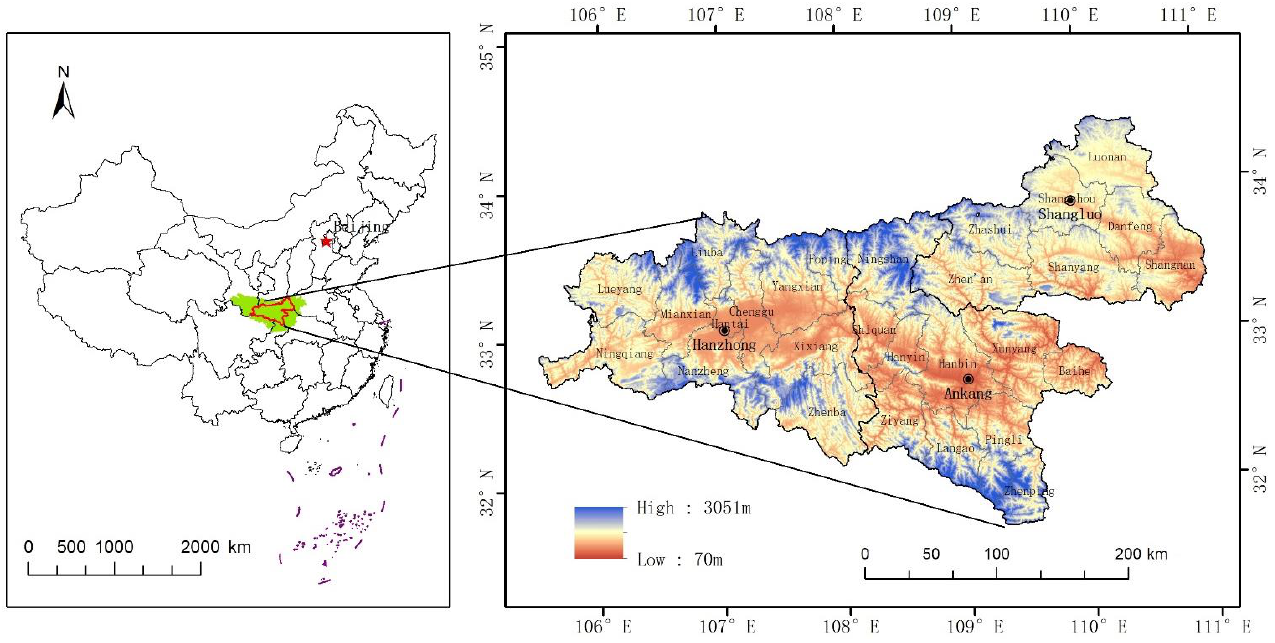
Figure 1. Overview of the study area.